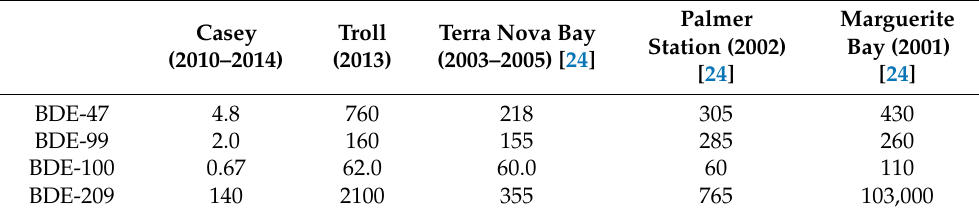
Table 3. Comparison of selected average PBDE congeners in Antarctic air in the vicinity of active research stations (fg/m 3